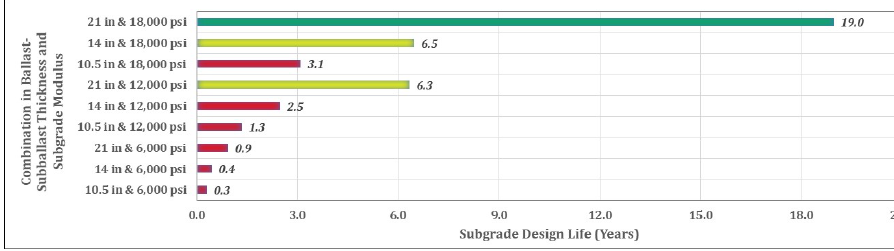
Figure 28: Influence of subgrade modulus and ballast-sub-ballast thickness on subgrade service life in the granular rail